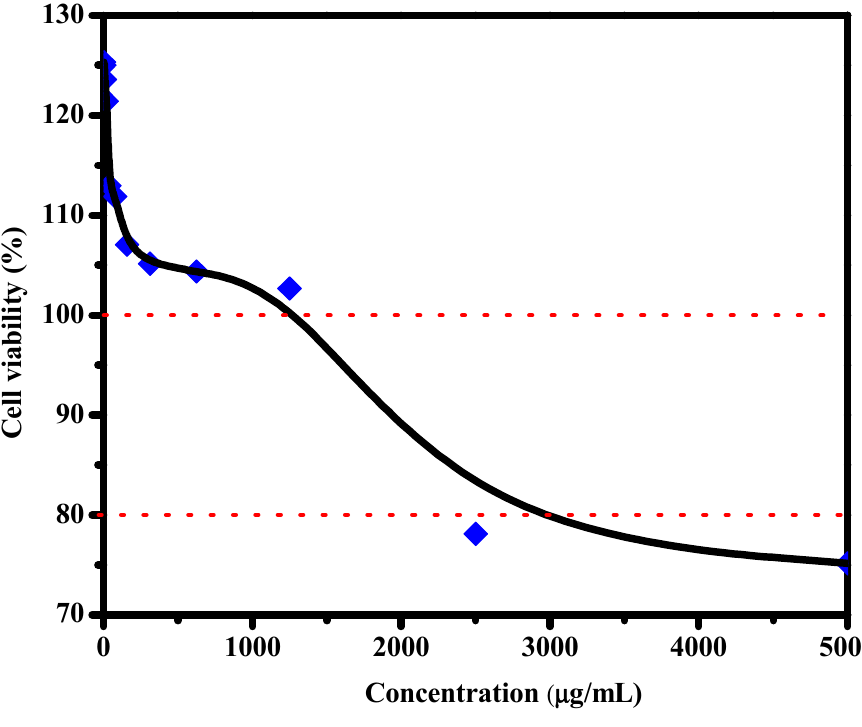
Figure 6. Cell viability of normal lung cells upon different Ag 2 O/ZnS/GO/CA concentrations. Cytotoxicity and cell viability are tests to measure viable normal cells, while antibacte- rial activity is a test to study the behavior of the scaffold against bacterial invasion, which could cause skin